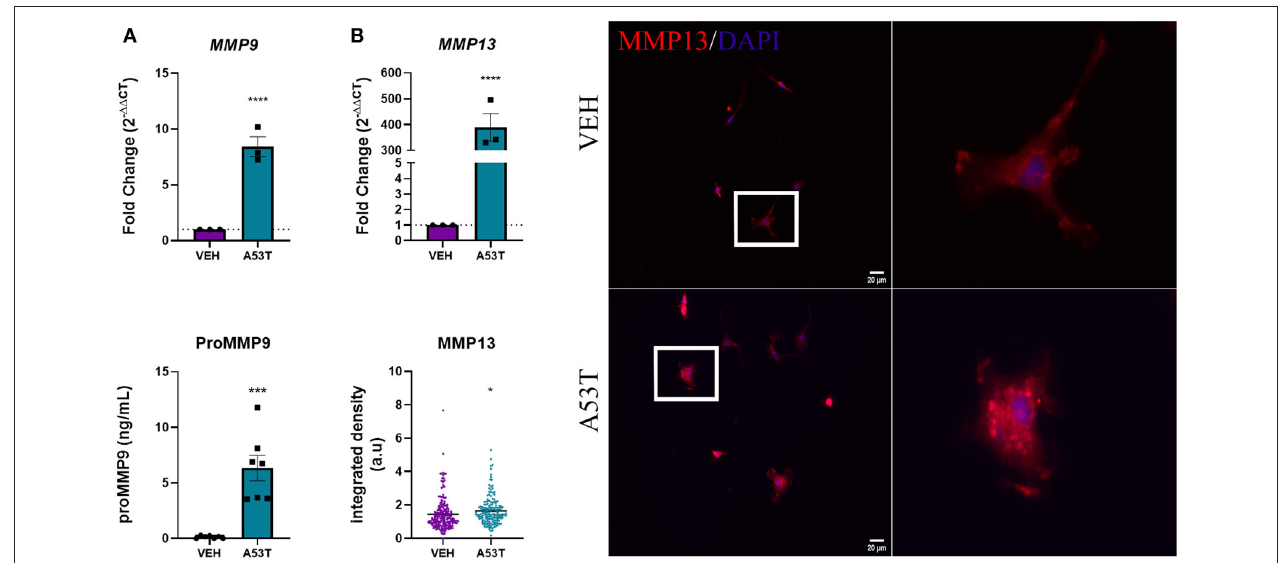
FIGURE 6 | Microglia-derived MMPs are upregulated in response to A53T. Microglia were exposed to 1 µ g/mL misfolded A53T or vehicle (VEH) for 24h and evaluated for changes in MMP expression and release. (A) A53T exposure upregulated MMP9 expression ( n = 3 wells/treatment) and protein release ( n = 7 wells/treatment) compared to vehicle-treated cells. (B) A53T exposure increased MMP13 mRNA expression and MMP13 protein (integrated density following MMP13 immunocytochemistry red; DAPI, blue) compared to vehicle treatment (VEH n = 194 cells and A53T n = 171 cells). Values are reported as mean ± SEM, using an